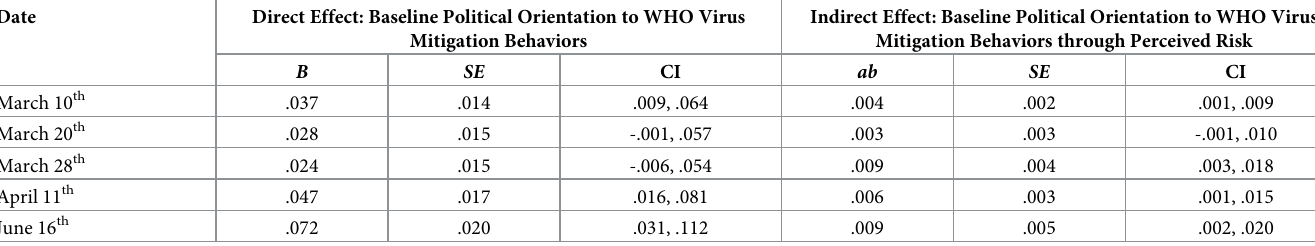
Table 3. Tests of the mediational model in five time points: Study 1. Direct Effect: Baseline Political Orientation to WHO Virus Mitigation